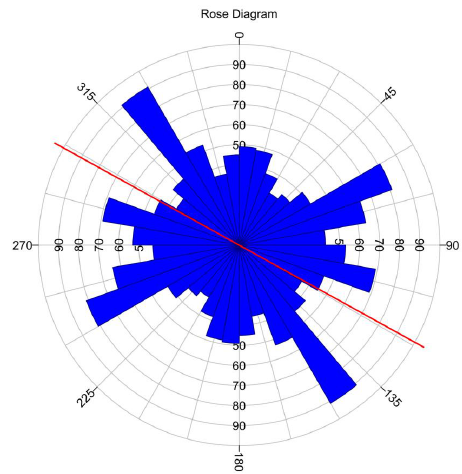
Figure 15. Rose diagram of the obtained results.